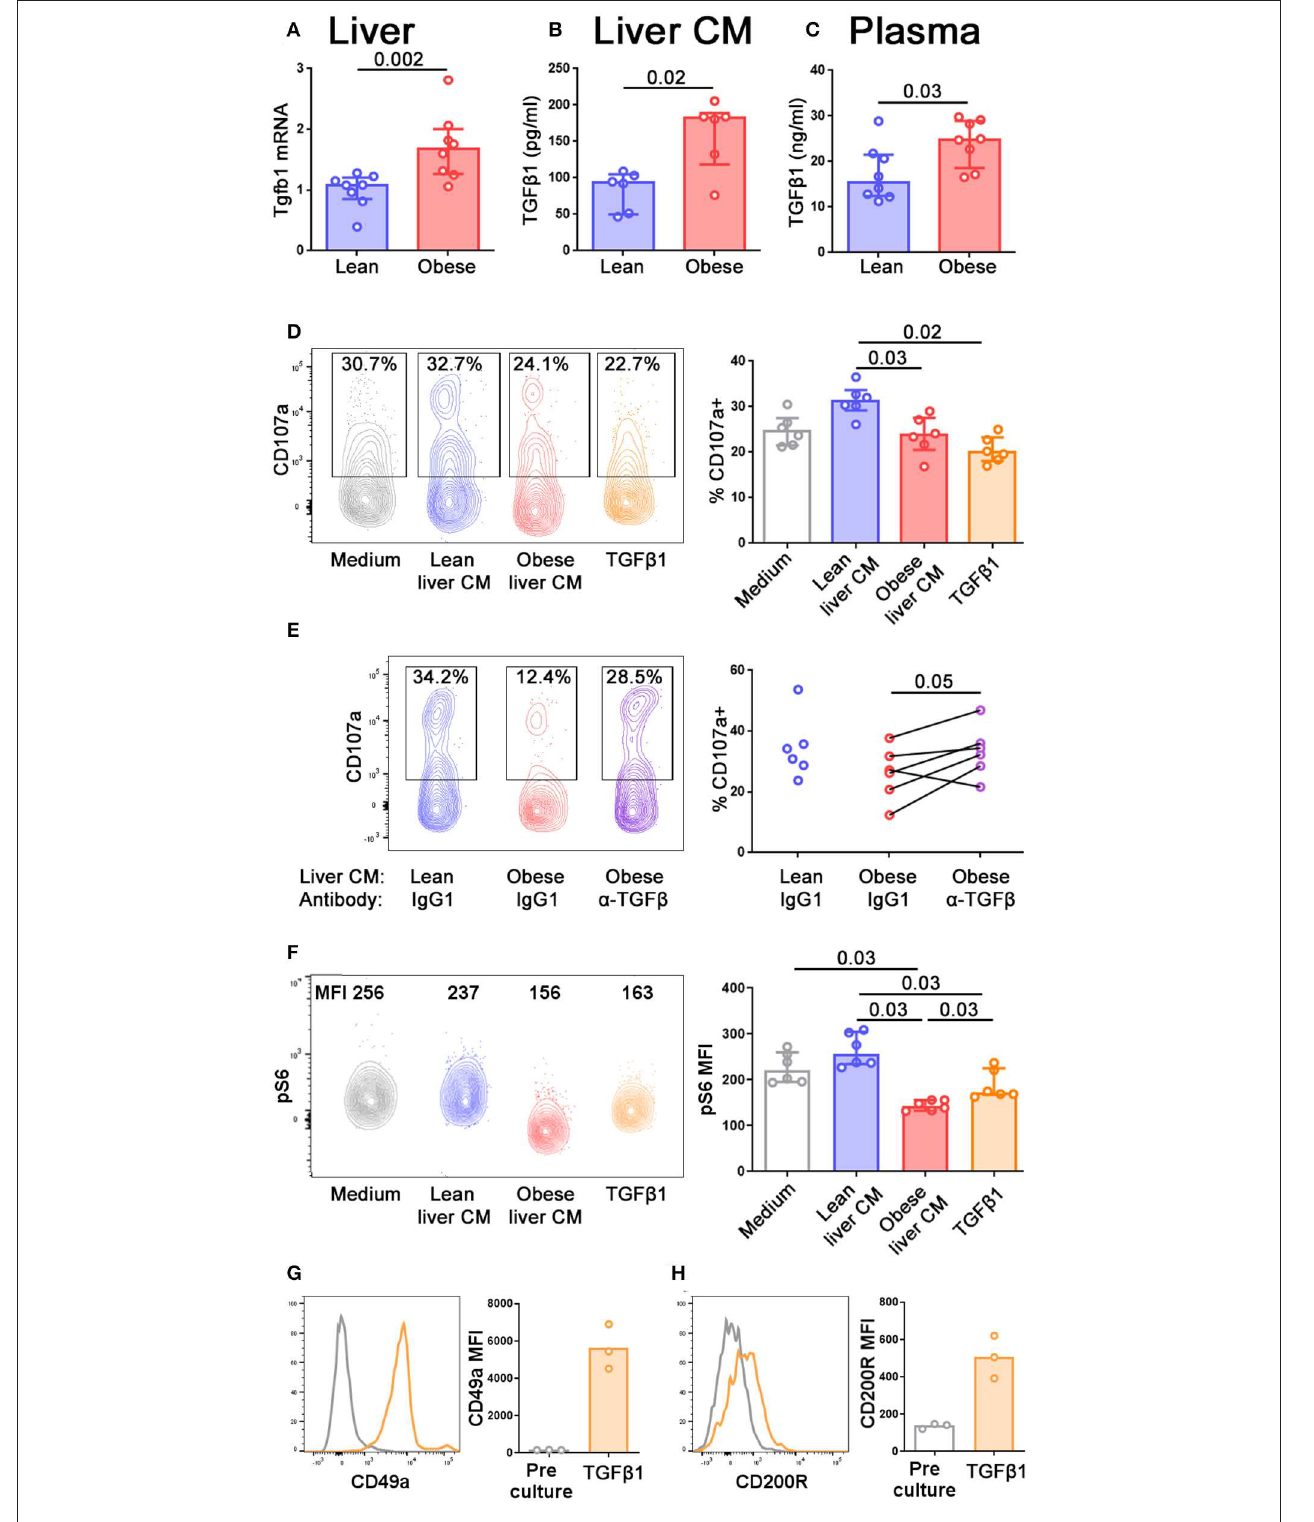
FIGURE 5 | TGF β in obese mouse livers limits NK cell degranulation and alters their metabolic profile. (A) Tgfb1 mRNA in the livers of lean and obese mice, normalized so that mean Tgfb1 transcript expression in the livers of lean mice = 1. (B,C) TGF β 1 in lean and obese liver conditioned medium (B) and lean and